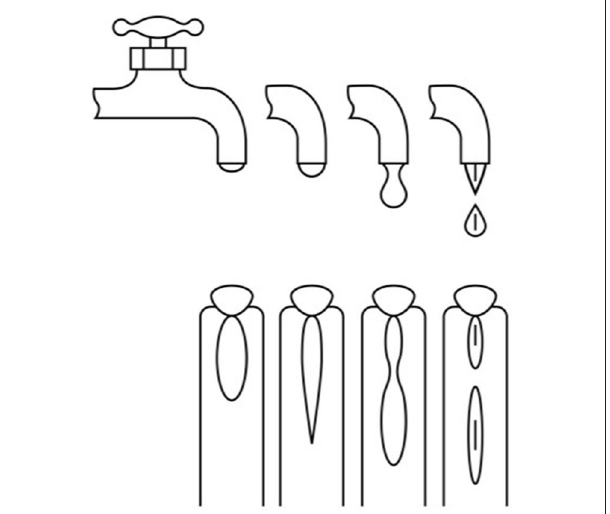
FIGURE 4 | An illustration of the analogy between a dripping faucet and the formation of large-scale plasmoid in Earth’s magnetotail during a magnetospheric substorm (from Hones, 1979). This concept has been extended to develop non-linear analog models of substorms.